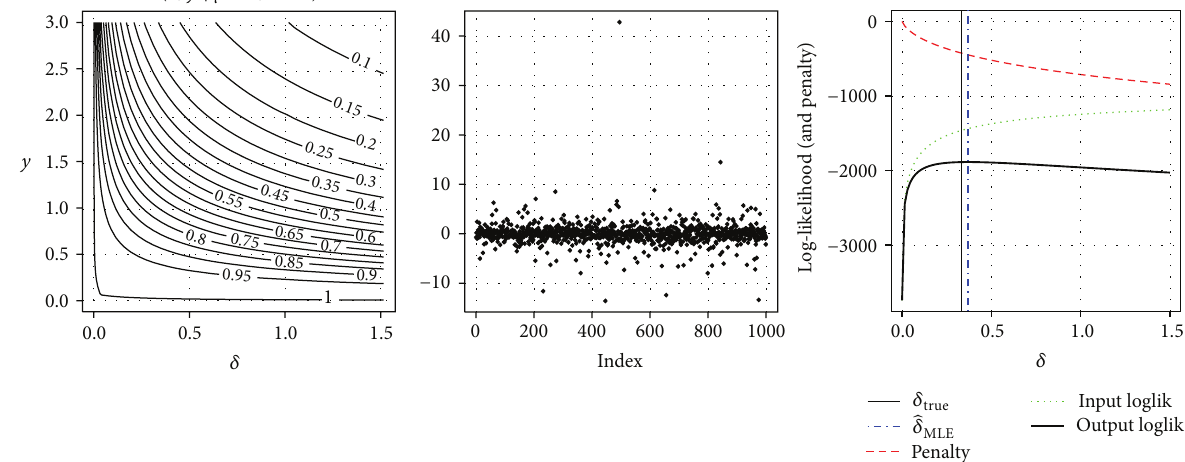
(b) Sample z of Lambert W × Gaussian with 𝛿 = 1/3 (left); log-likelihood ℓ(𝜃; y ) (solid, black) decomposes in input log-likelihood (dotted, green) and penalty (dashed, red) Figure 6: Log-likelihood decomposition for Lambert W × 𝐹 𝑋